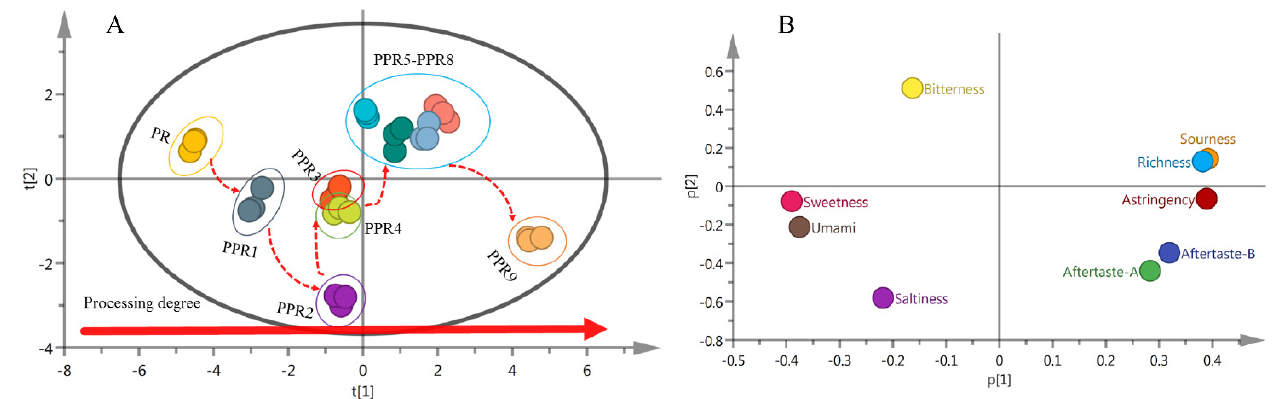
Figure 5. Principal component analysis PCA biplots for 10 different processed PR samples based on E–tongue response data: ( A ) Score plot; ( B ) loading plot.